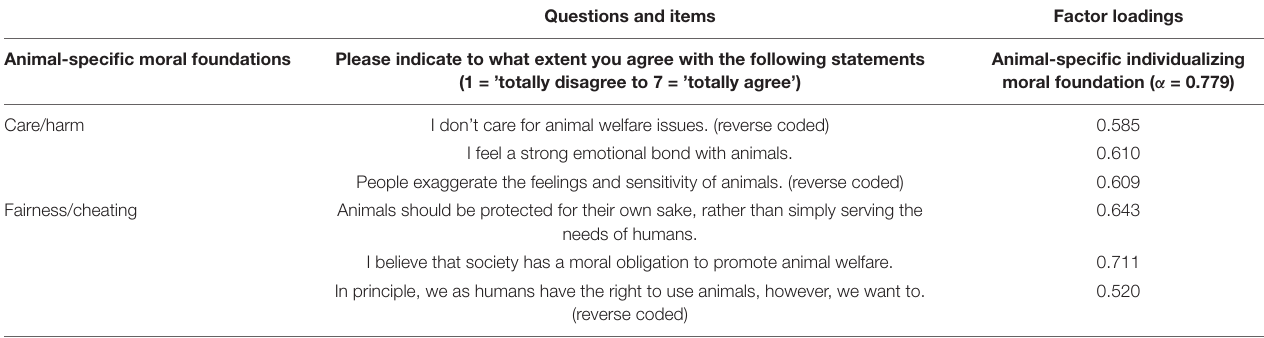
TABLE 7 | Factor matrix of the animal-specific moral value items (Study 3).